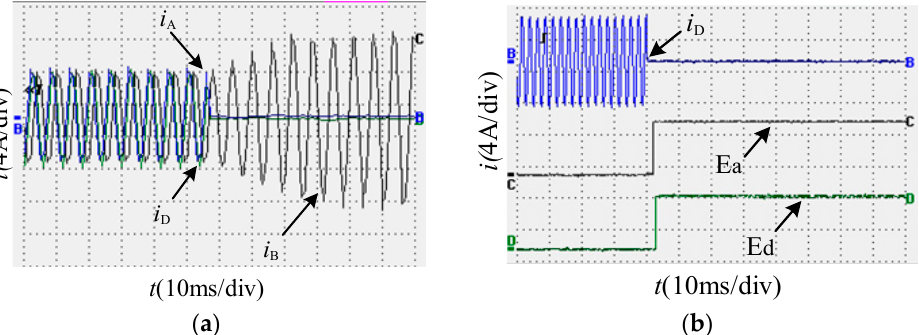
Figure 30. Phase current and fault index waveform in case of phase failure of phase a and phase d : ( a ) fault current waveform; ( b ) fault phase current and fault index waveform.